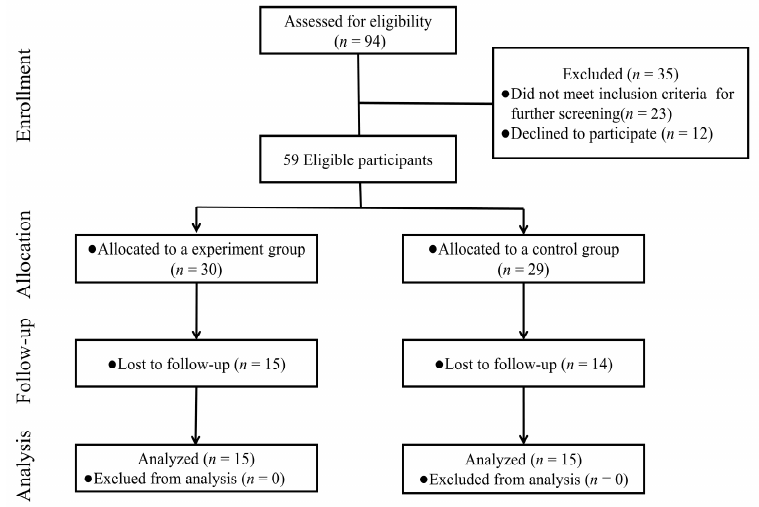
Figure 1. Participant follow chart.